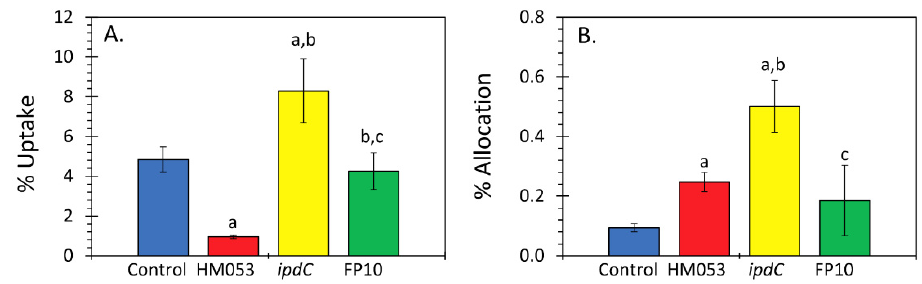
Figure 3. (Panel A ): ‘Cut and count’ measurements yielded information on plant uptake of 65 Zn presented as the percentage of tracer dose administered to the beaker that was assimilated by the plant over 3 hours. (Panel B ): Root-to-shoot allocation of 65 Zn is presented as the percentage of the administered dose of radiotracer. Data reflect means for N = 5-6 replicates ( ± SE). Statistical signifi- cance p < 0.05 was designated by ‘a’ in a comparison of treatment to control, ‘b’ in a comparison of ipdC or FP10 to HM053, and ‘c’ in a comparison of FP10 to ipdC treatment.